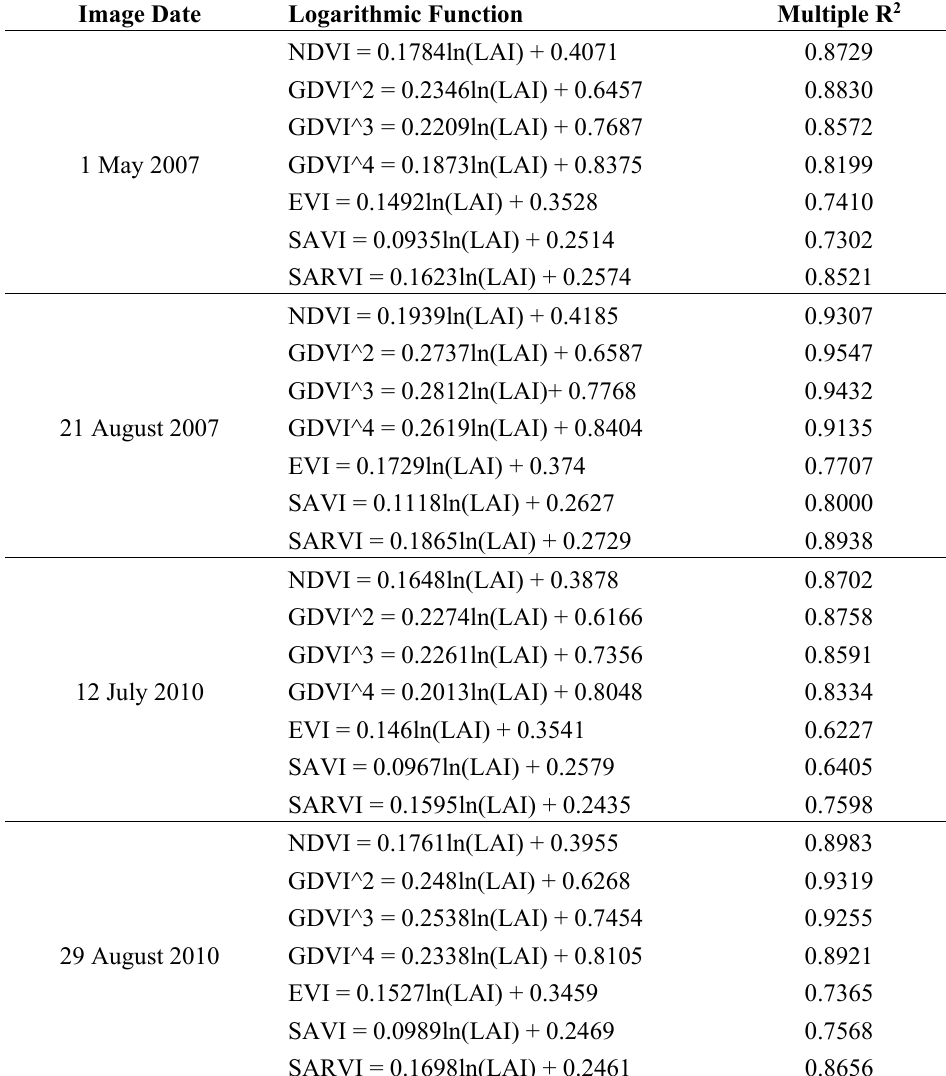
Table 7. Values of vegetation indices of some typical biomes (Landsat image